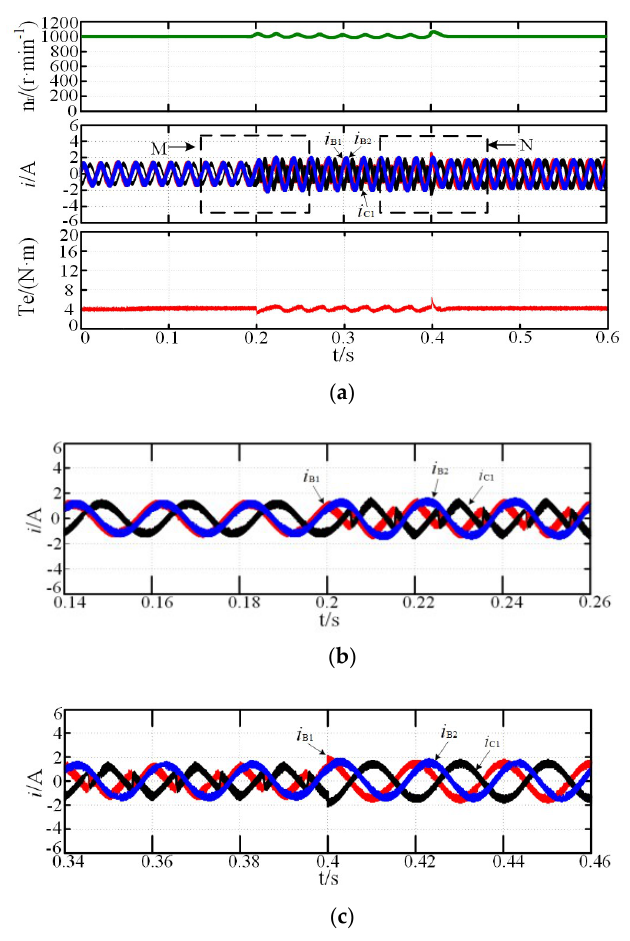
Figure 7. Simulation of fault-tolerant operation: ( a ) MTO; ( b ) magnification of M region; ( c ) magnification of N region.